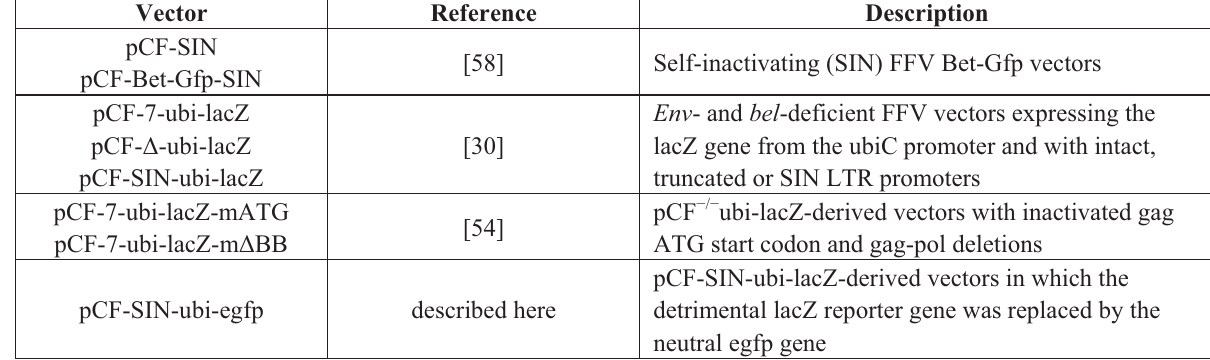
Table 2. Selected replication-deficient FFV vectors and their